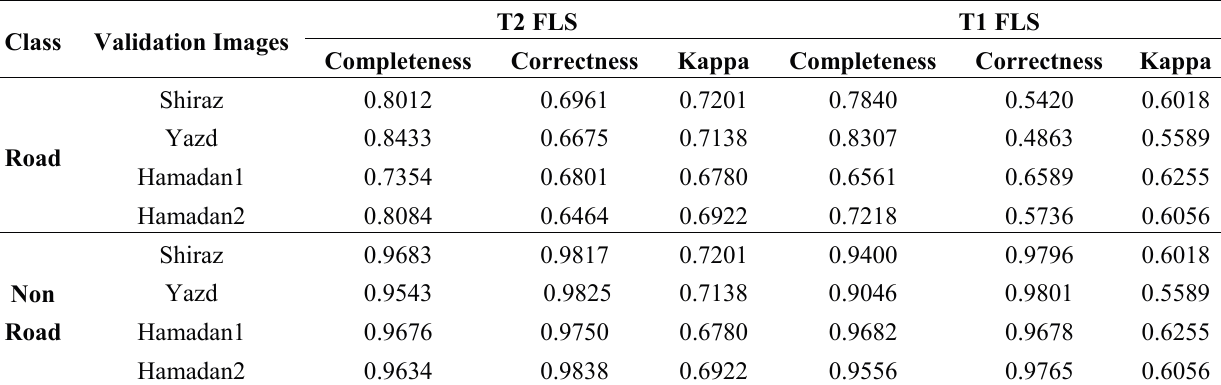
Table 7. Validation results of optimized T1 and T2